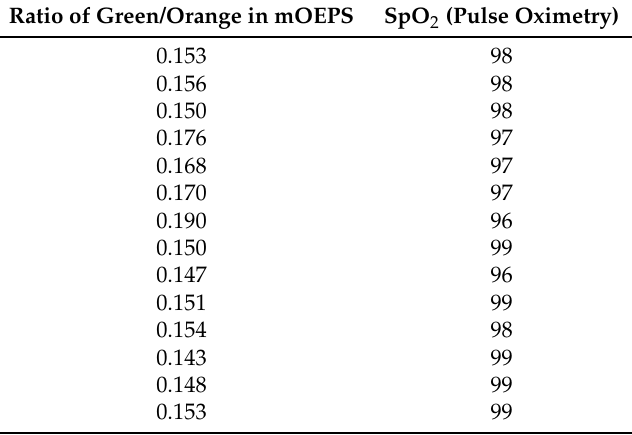
Table 1. The values of Ratio ( R ) and SpO 2 (%) used in the calculation of the coefficients A and B. Ratio of Green/Orange in mOEPS